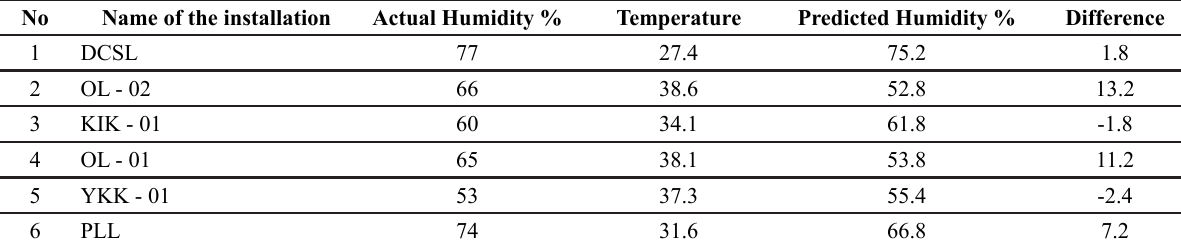
Table 4: Observations of humidity data analysis.